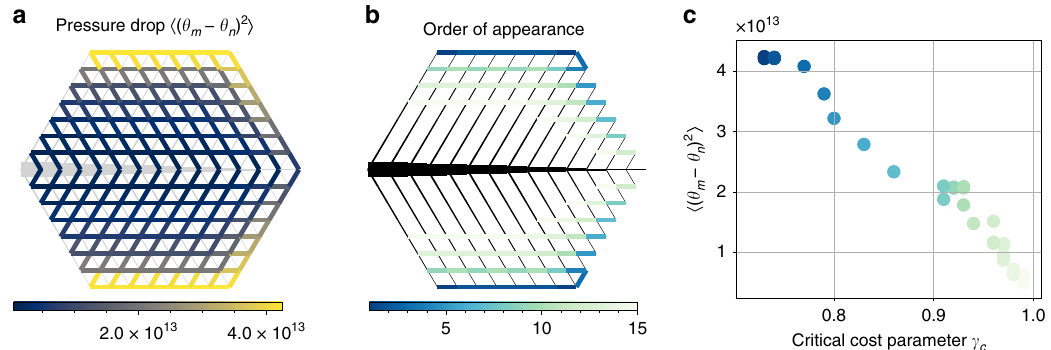
Fig. 5 Average pressure drop predicts the order of appearance of new loops as the cost parameter is varied. a The average squared pressure drop hð θ (cid:2) θ Þ 2 i (colour code, cf. Eq. (28)) calculated for the global tree optimum of dissipation allows predicting the location of the edges where loop m n formation fi rst becomes bene fi cial. b Starting from a globally optimal tree network with cost parameter γ = 0.4, we slowly increase the cost parameter. We then determine in which order and at which critical value of the critical cost parameter γ c new edges appear closing a loop. c The pressure drop is strongly correlated with the critical cost parameter γ c where the given loop starts to form. Colour code corresponds to order of appearance of edges from dark ( fi rst) to